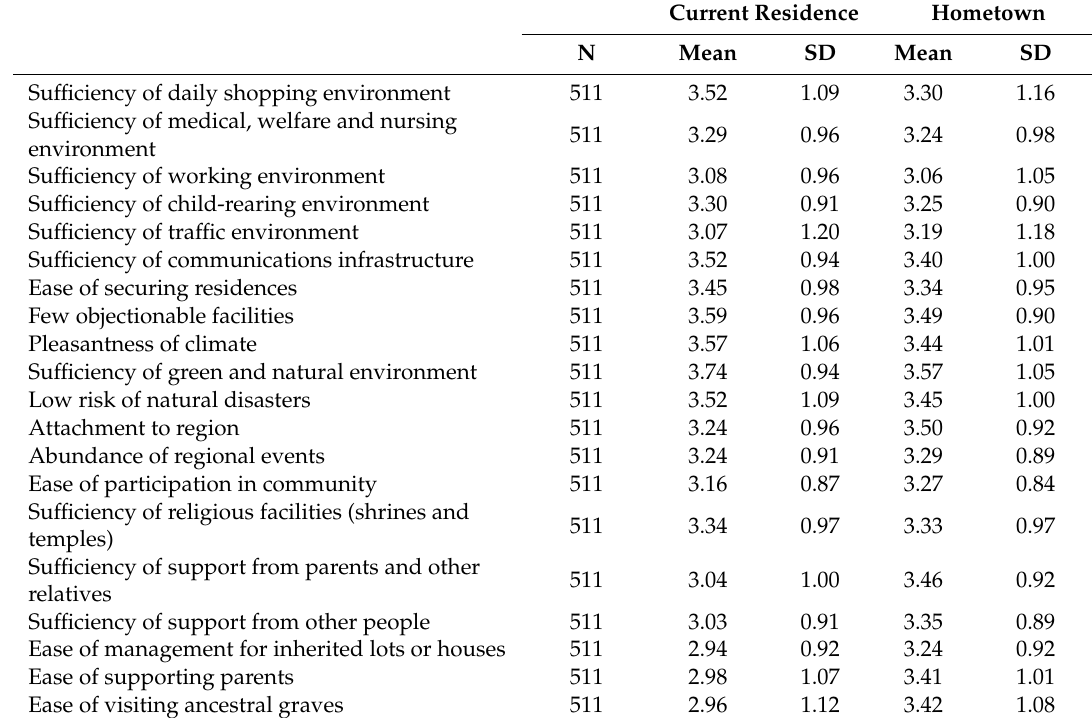
Table 2. A list of living environments and respondents’ evaluations.